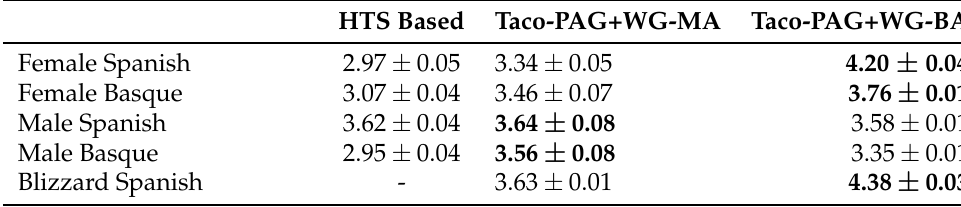
Table 4. NISQA assessment scores with 95% confidence